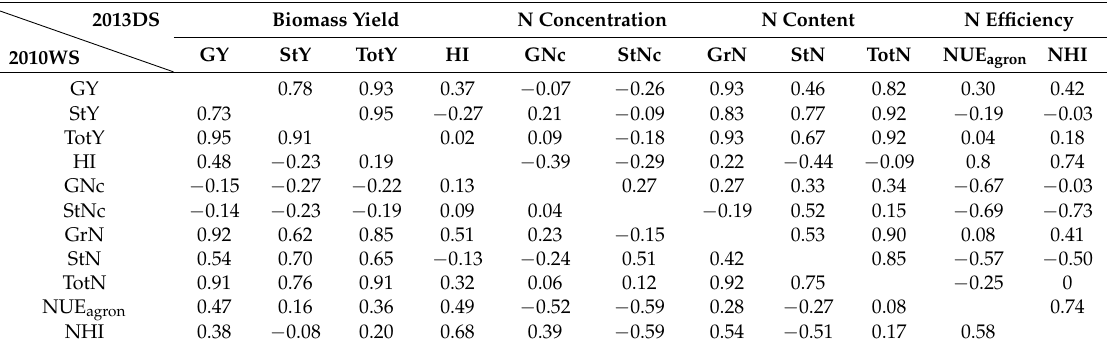
Table 2. Correlations between key biomass and N parameters in wet season (WS) and dry season (DS) field